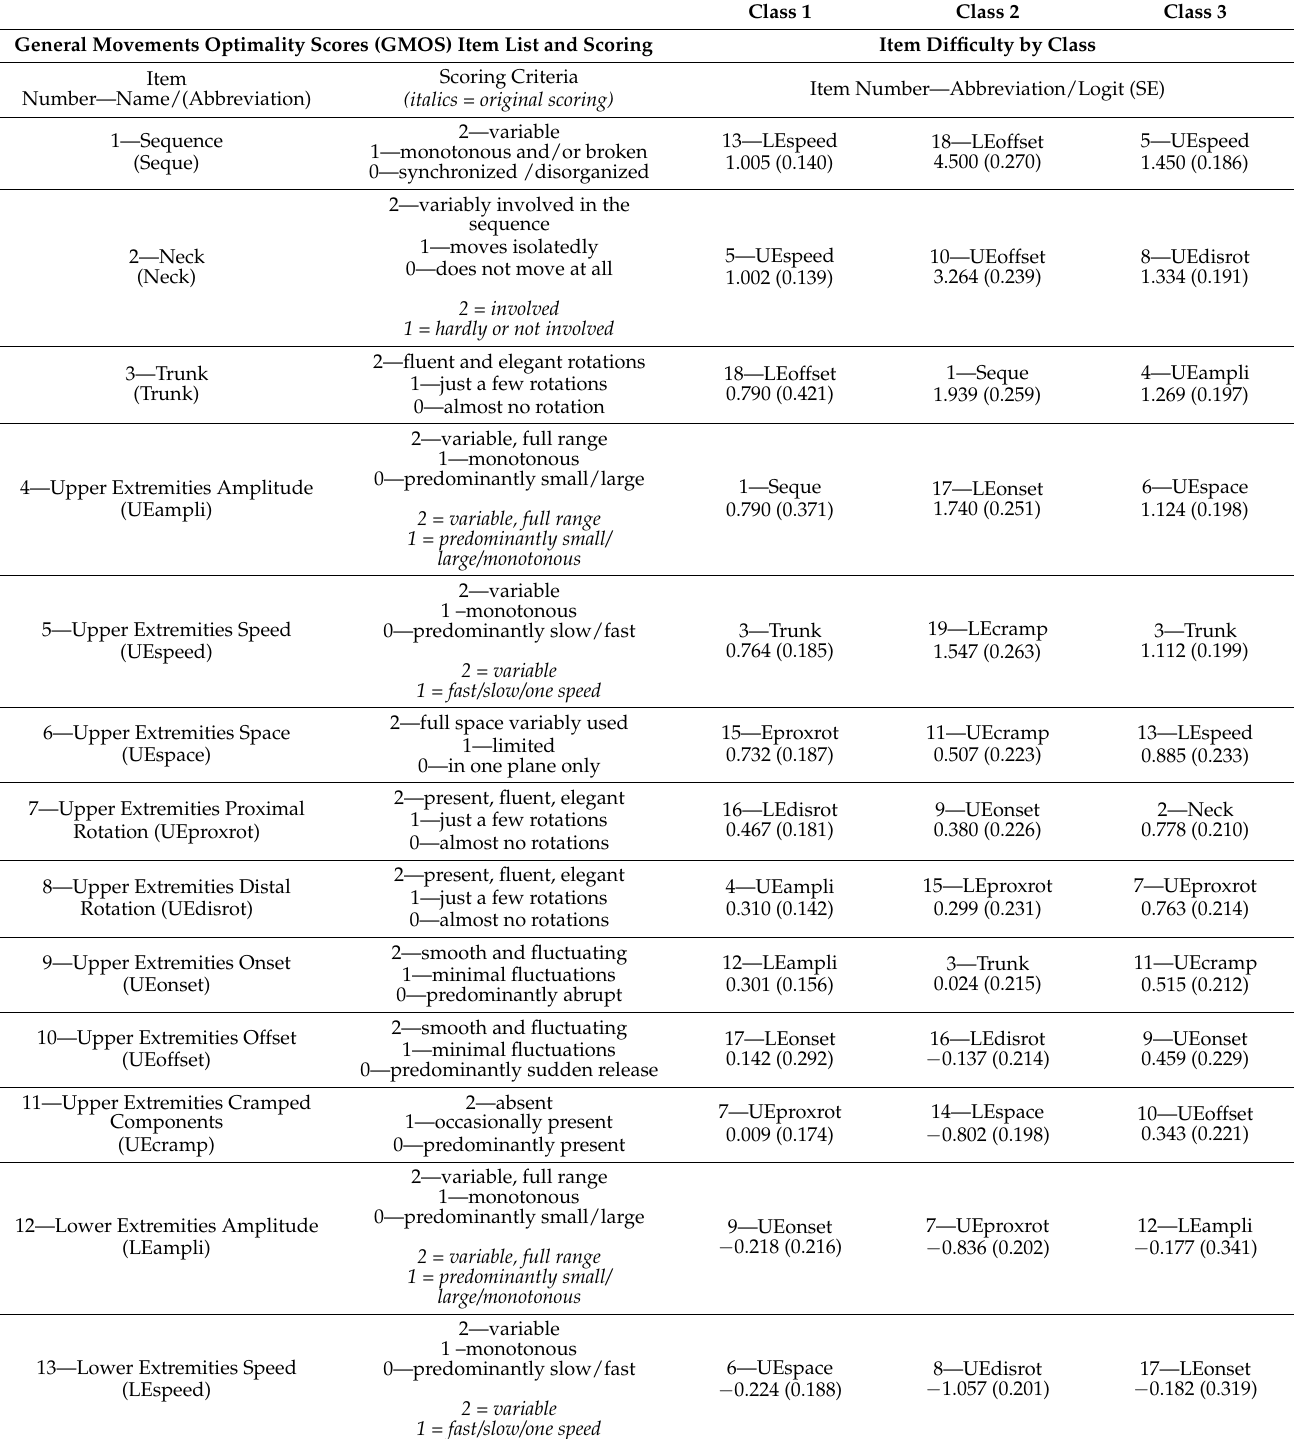
Class 1 Class 2 Class